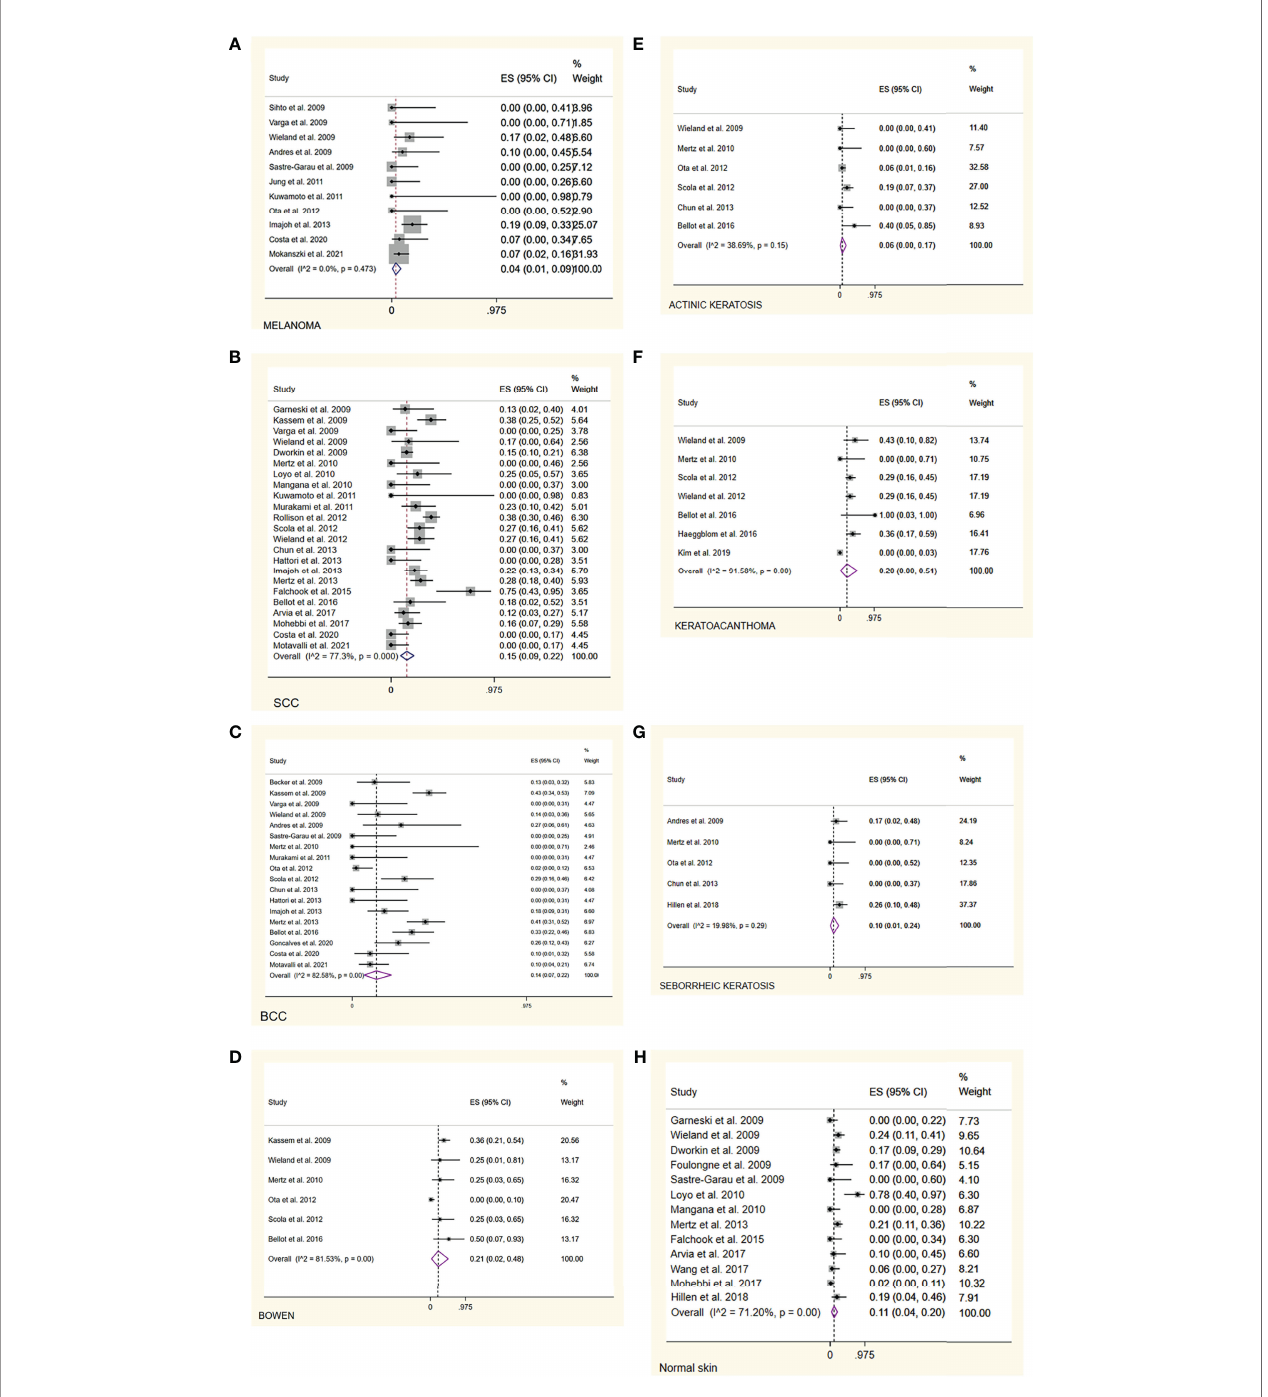
FIGURE 4 | Forest plot illustrating the pooled prevalence rate of the MCPyV positivity in non-MCC skin lesions and normal skin. (A) melanoma; (B) squamous cell carcinoma; (C) basal cell carcinoma; (D) Bowen ’ s disease; (E) actinic keratosis; (F) keratoacanthoma; (G) seborrheic keratosis; (H) normal